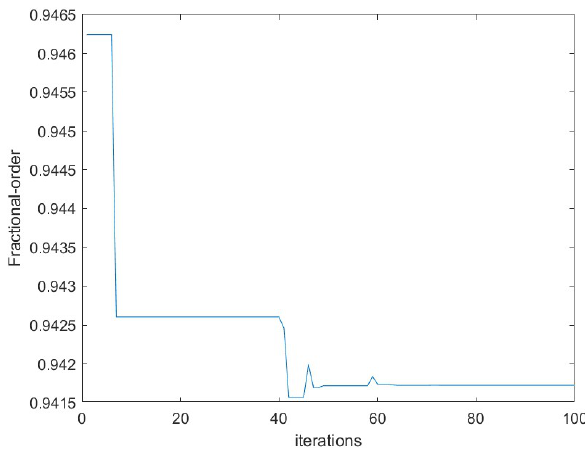
Figure 5. Fractional-order convergence process of model 4.